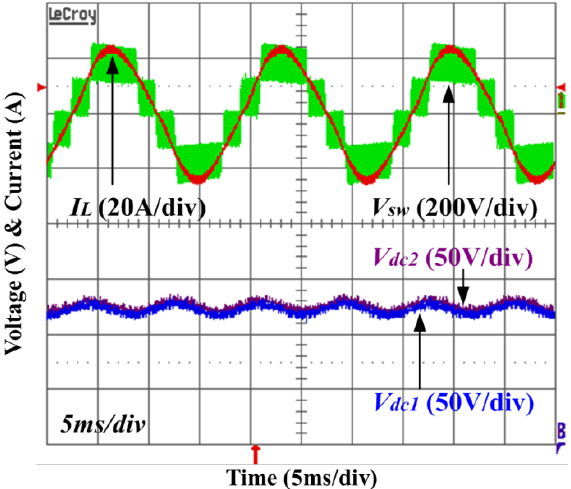
Figure 13. Experimental results of DC link voltage and grid current control when the MPP voltage of upper H-bridge module and lower H-bridge module are 120 V respectively.